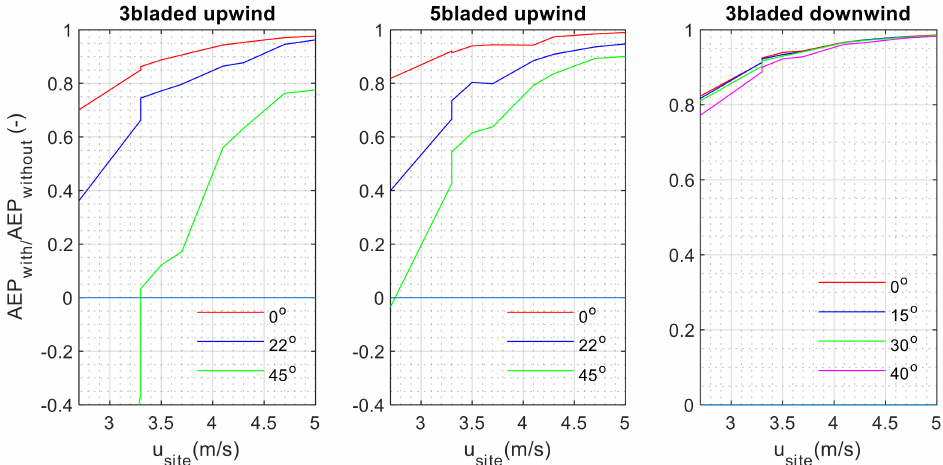
Figure 17. Ratio of Annual Energy Production with and without the standby losses plotted for increasing mean wind speed u site (m/s) per different site and different yaw angles θ ( ◦